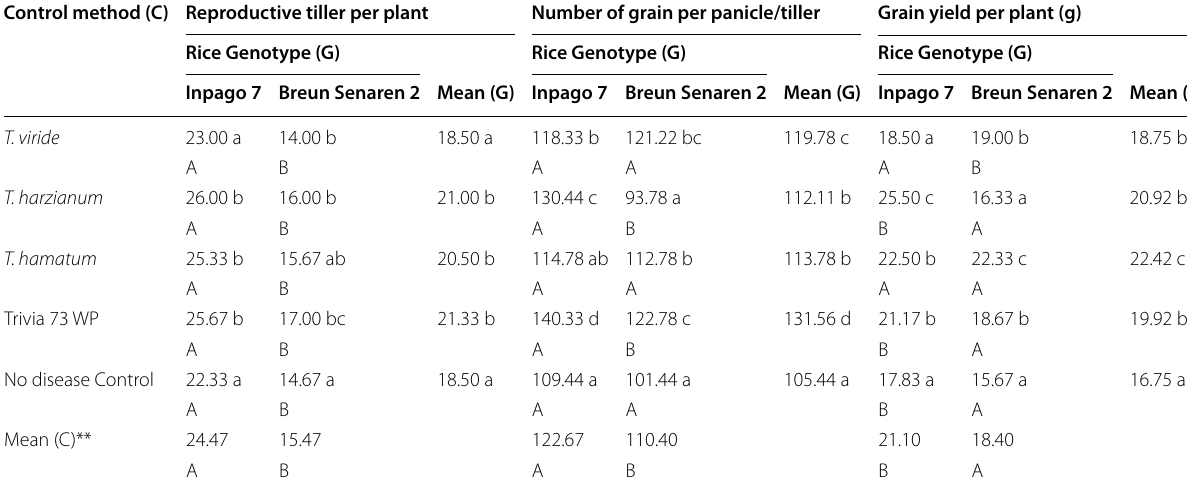
Lowercase denotes comparison within the same column, and uppercase indicates comparison within the same row. Values within the same column/row with the identical lowercase or uppercase are not significantly different based on the LSD (0.05) post hoc test